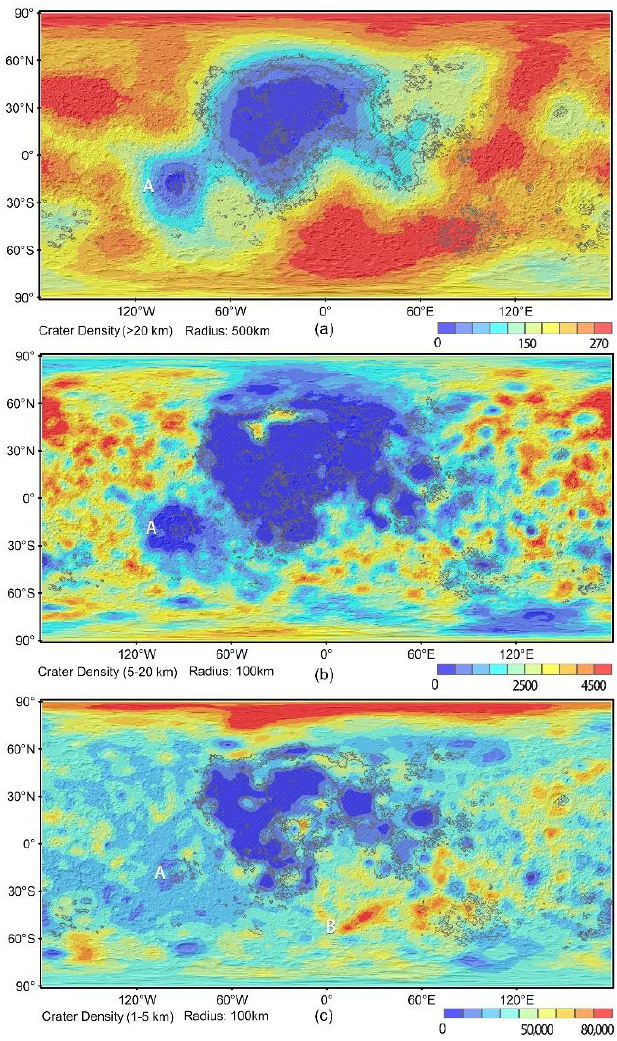
Figure 4. Global normalized crater density maps for (a) >20 km, (b) 5-20 km and (c) 1-5 km. The lunar mare regions are marked by grey slashes.